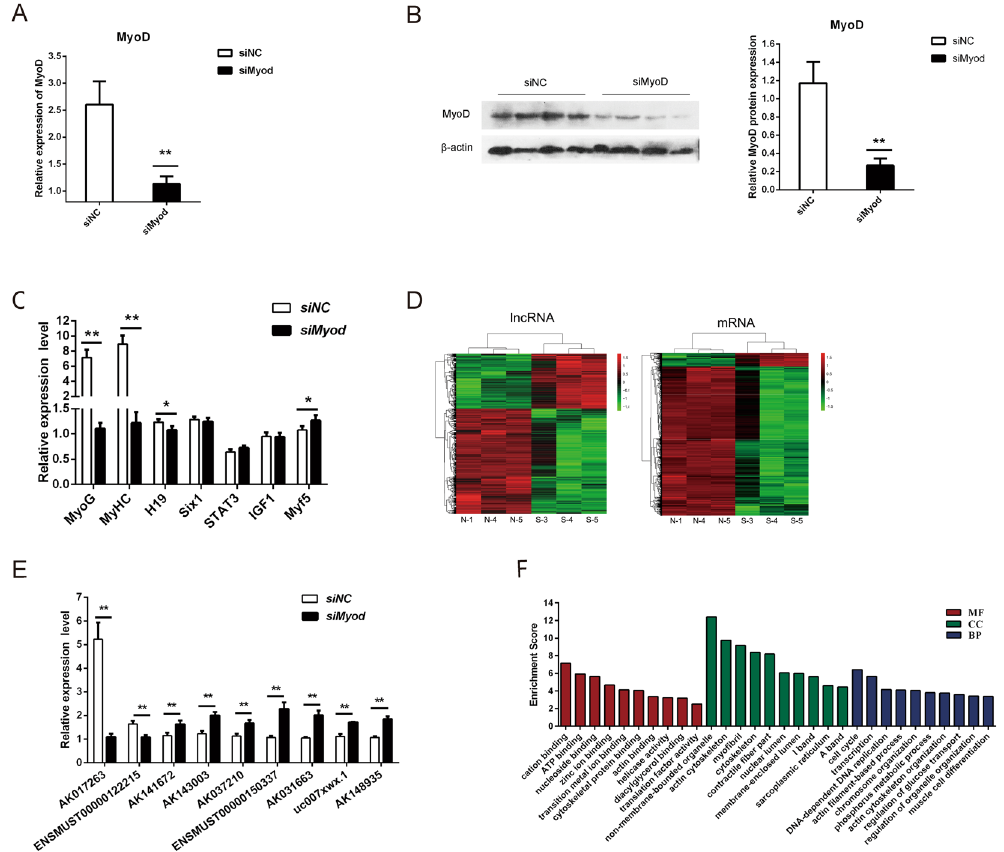
Figure 1. Analysis of differential gene expression profile by MyoD interference. ( A and B ) Knockdown of MyoD by siRNA oligos in differentiated C2C12 cells for 48 h ( C ) The mRNA level of MyoD downregulated or upregulated genes expression after MyoD silencing. ( D ) Hierarchical clustering dendrogram depicted the relationships among the dysregulated lncRNA expression patterns of samples (fold change ≥ 1.5; p < 0.05) at 48 h differentiation after siMyoD or control oligo treatment. The colors corresponded to a normalized expression value of each transcript (red: high relative expression; green: low relative expression). ( E ) The differential expression of MyoD-mediated lncRNAs was validated by quantitative real-time PCR. All the qPCR data were normalized to β -actin and presented as mean ± S.D. (n = 3). * p < 0.05, ** p < 0.01. ( F ) The GO annotations of the co-expression genes correlated to lncRNAs. The top 10 enriched GO term of dysregulated mRNAs are shown for biological process (BP), cellular component (CC) and molecular function (MF) according to the values in the fold